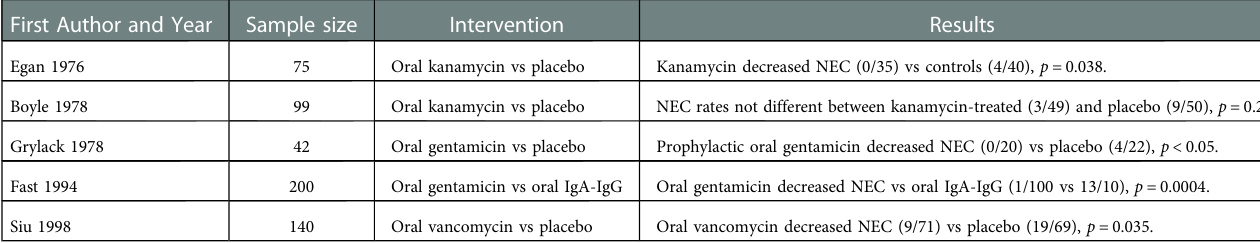
TABLE 1 Randomized controlled trials of prophylactic oral antibiotics to reduce